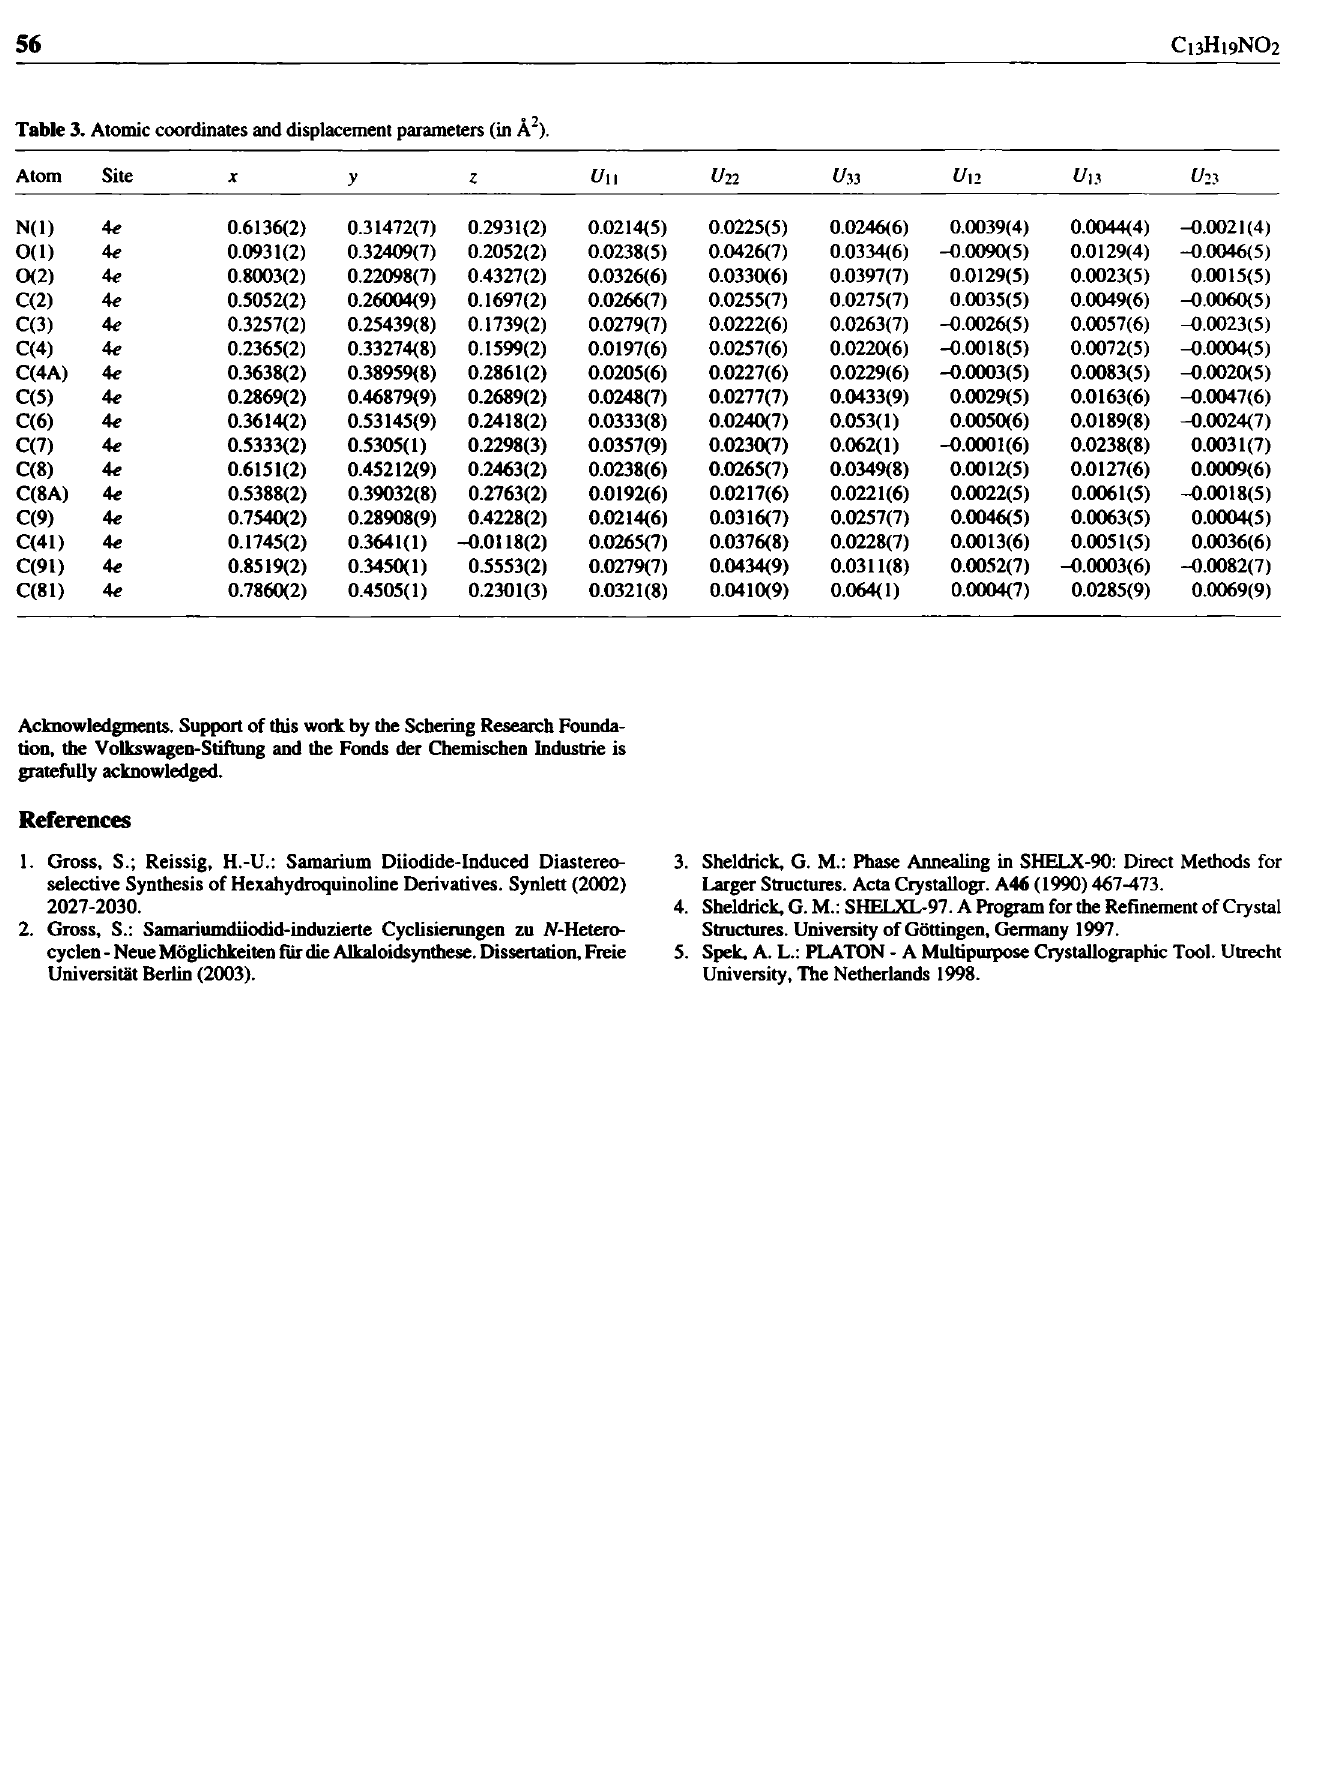
Table 3. Atomic coordinates and displacement parameters (in A 2